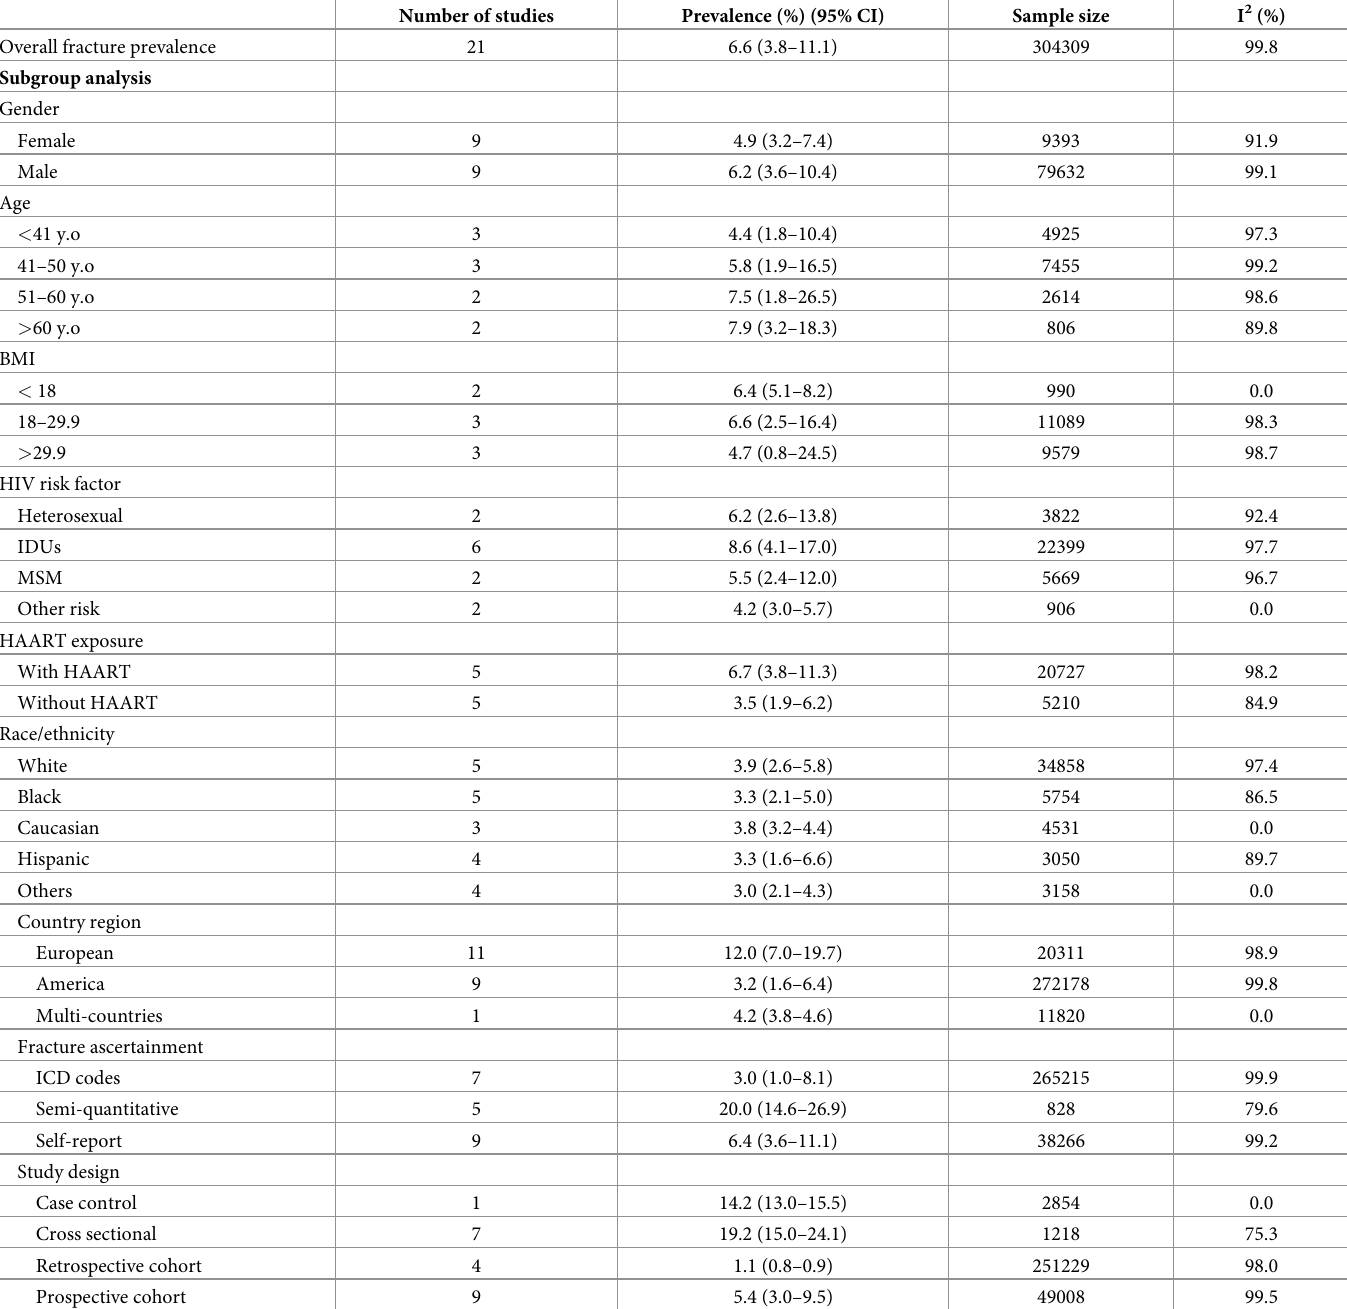
Table 2. Prevalence of fracture among people living with HIV by demographic variable in selected